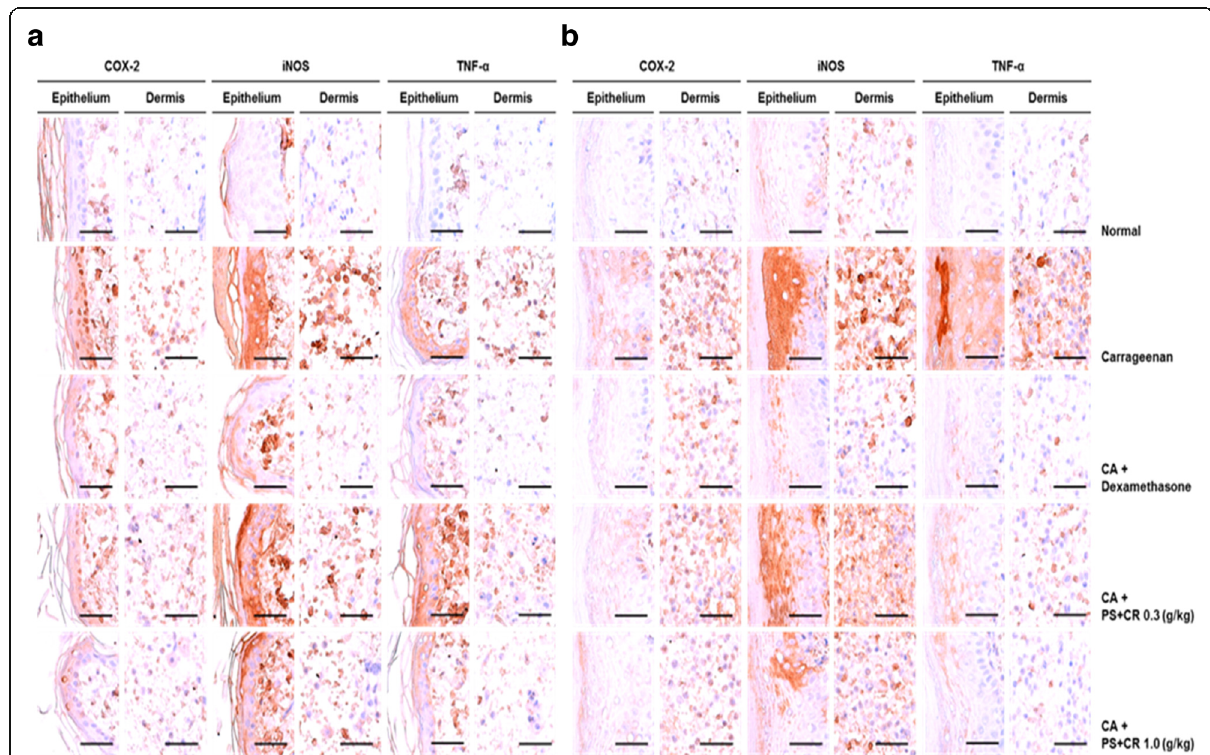
Fig. 8 Representative immunohistochemical profiles of COX-2, iNOS, and TNF- α in paw skin. Marked increases of COX-2, iNOS, and TNF- α -positive cells were detected in the epithelium and dermis of the dorsum ( a ) and ventrum pedis skin tissues ( b ) in CA-treated rats compared with normal rats. Scale bars = 60 μ m